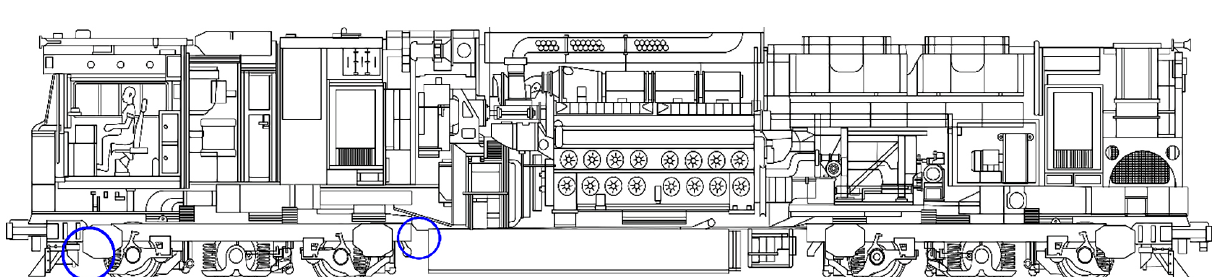
Figure 2. Transverse defect (foot fracture)